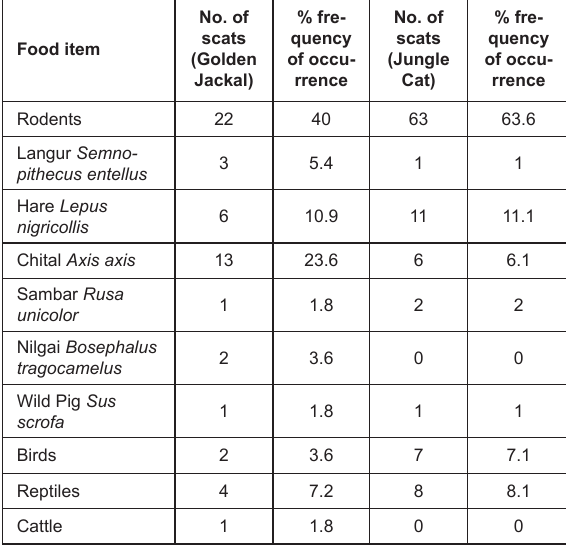
Table 1. Percentage frequency of food items recorded in scats of Golden Jackal and Jungle Cat in Pench Tiger Reserve, Madhya